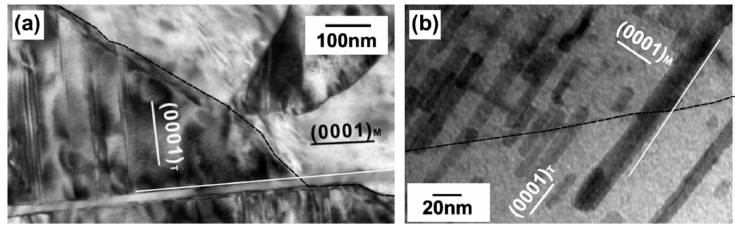
Figure 7. Interaction of a {10–12} twin and particles in peak-aged material ( a ) basal plate-shaped precipitate in AZ91 alloy. ( b ) c-axis rod-shaped precipitate in Mg-5%Zn alloy. The twin boundary has has been highlighted with a dashed line for clarity [4]. been highlighted with a dashed line for clarity [4]. Materials 2019 , 12 , x FOR PEER REVIEW